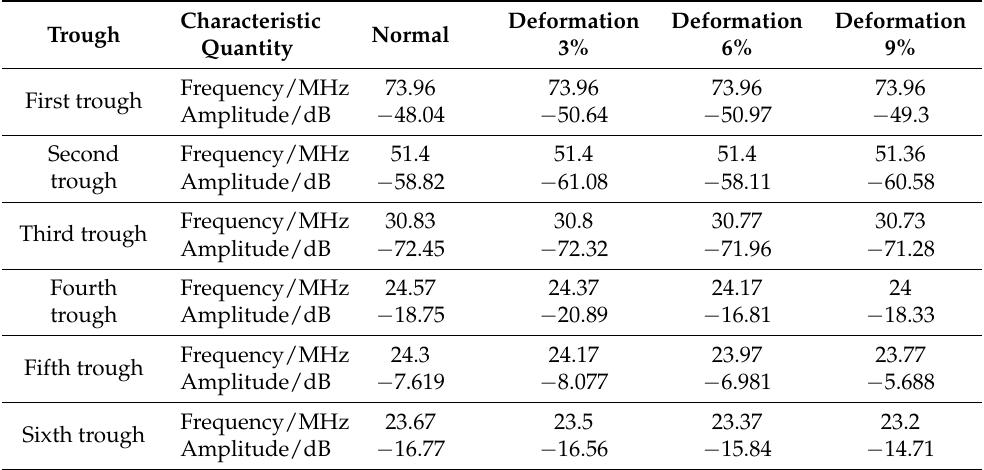
Figure 13. Frequency response curves of different winding inter-cake spacing: ( a ) Frequency response curve from 0 MHz to 100 MHz; ( b ) Frequency response curve from 20 MHz to 25 MHz; ( c ) Frequency response curve from 72 MHz to 76 MHz. Table 8. Influence of different inter-cake spacings of winding on frequency and amplitude of wave